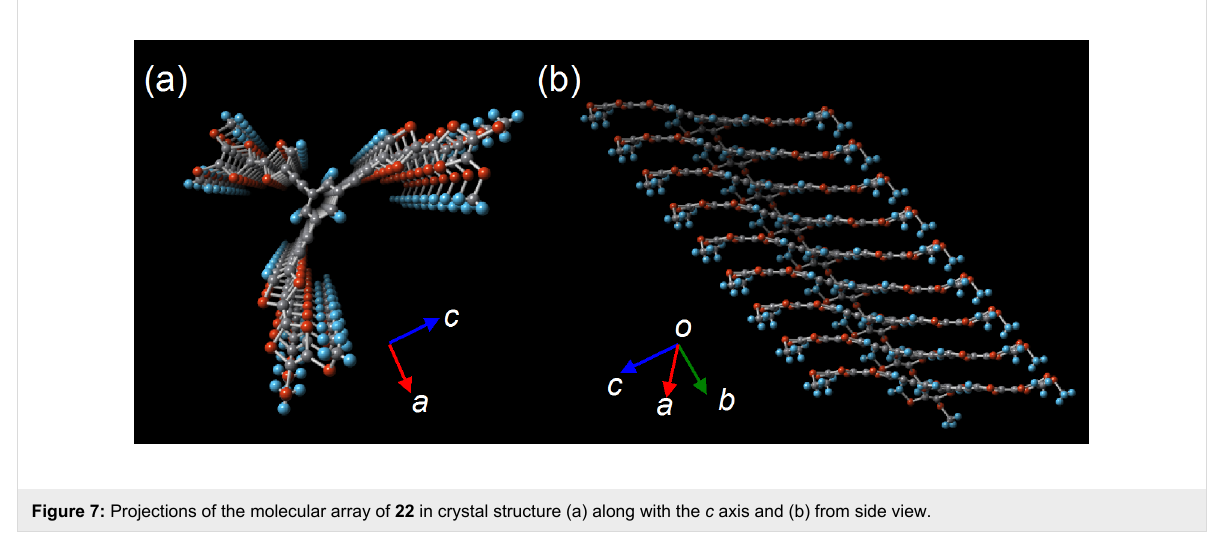
Figure 7: Projections of the molecular array of 22 in crystal structure (a) along with the c axis and (b) from side view.